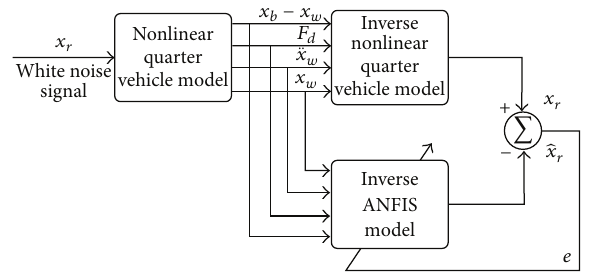
Figure 4: Structure of road estimation with